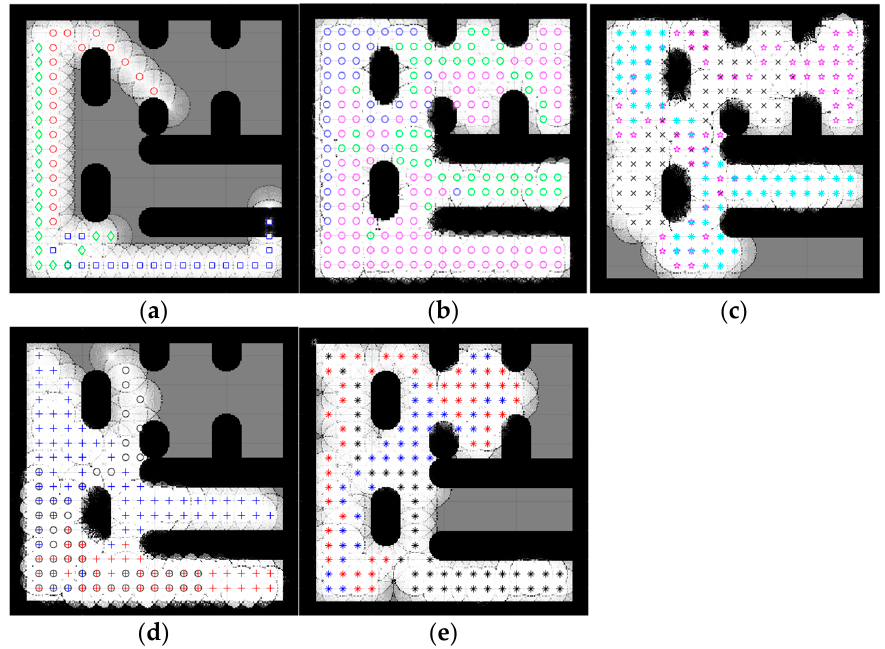
Figure 7. Percentage of the explored area after implementing the CME-SSA and the other approaches on complex map 1. Complex map 1: ( a ) CME, 39.24% (Iteration 21); ( b ) SSA, 98.36%; ( c ) CME-GWO, 86.88%; ( d ) CME-GWOSSA, 71.47%; ( e ) CME-SCA, 74.56%.